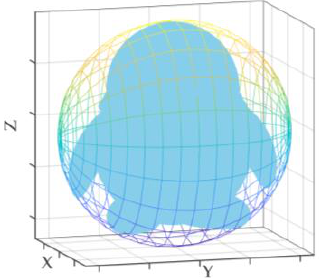
Figure 1. 3D penguin and its BS.